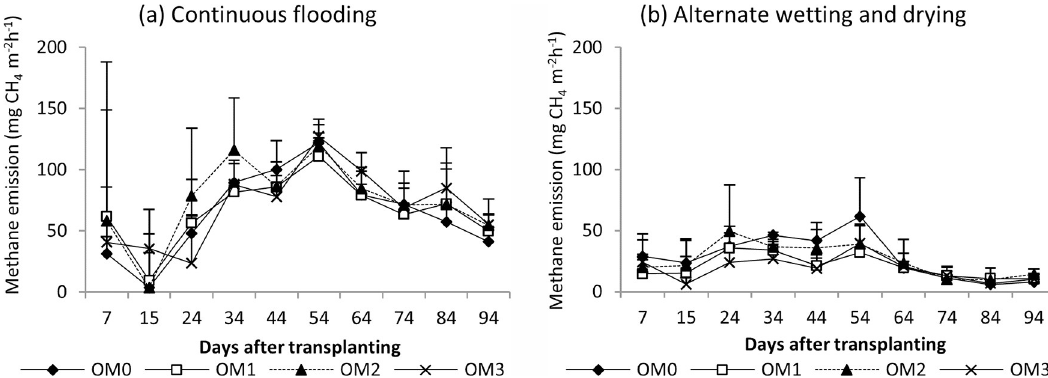
Table 4. Mean effects of water and manure management on greenhouse gases emission of rice during dry and wet seasons, 2017. Treatment